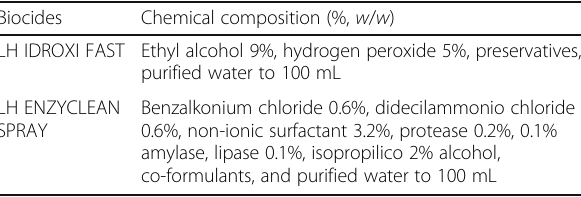
Table 1 Chemical characteristics of the two biocides used